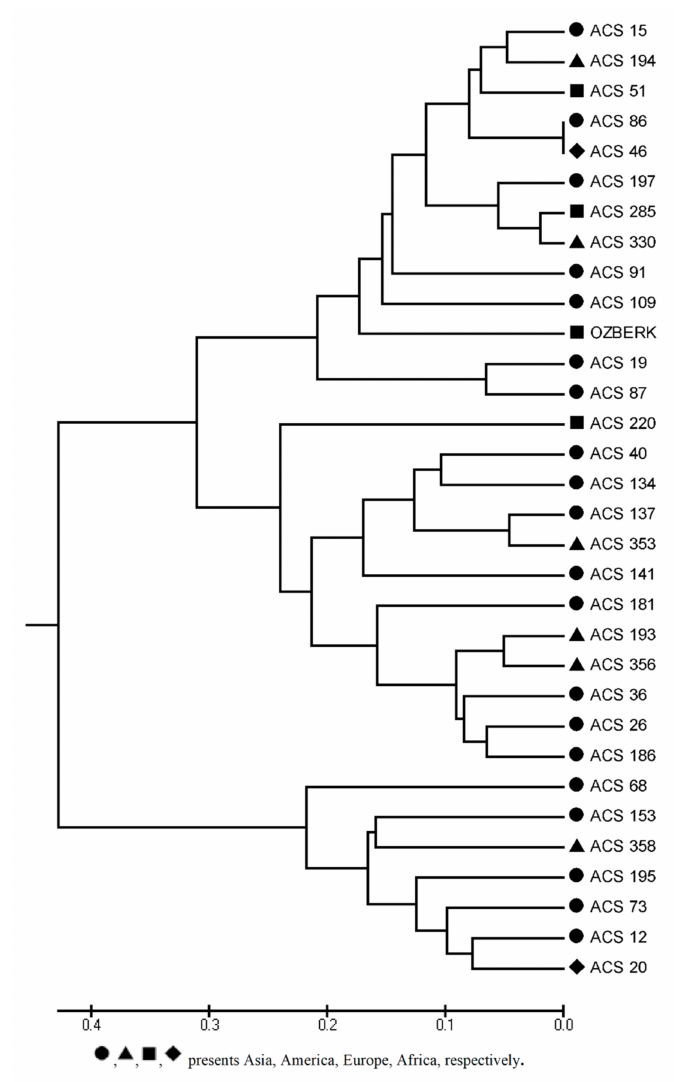
Figure 2. UPGMA dendrogram showing the genetic relationships among the 32 sesame